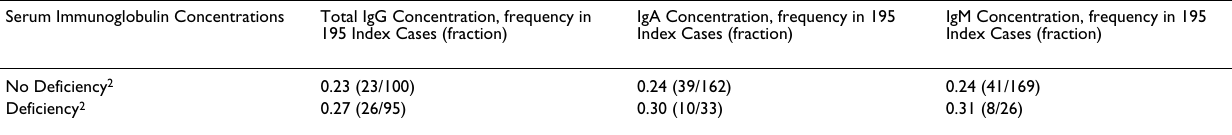
Table 7: CVID and IgGSD Index Cases Positive for Haplotype A*01-B*08. 1 Serum Immunoglobulin